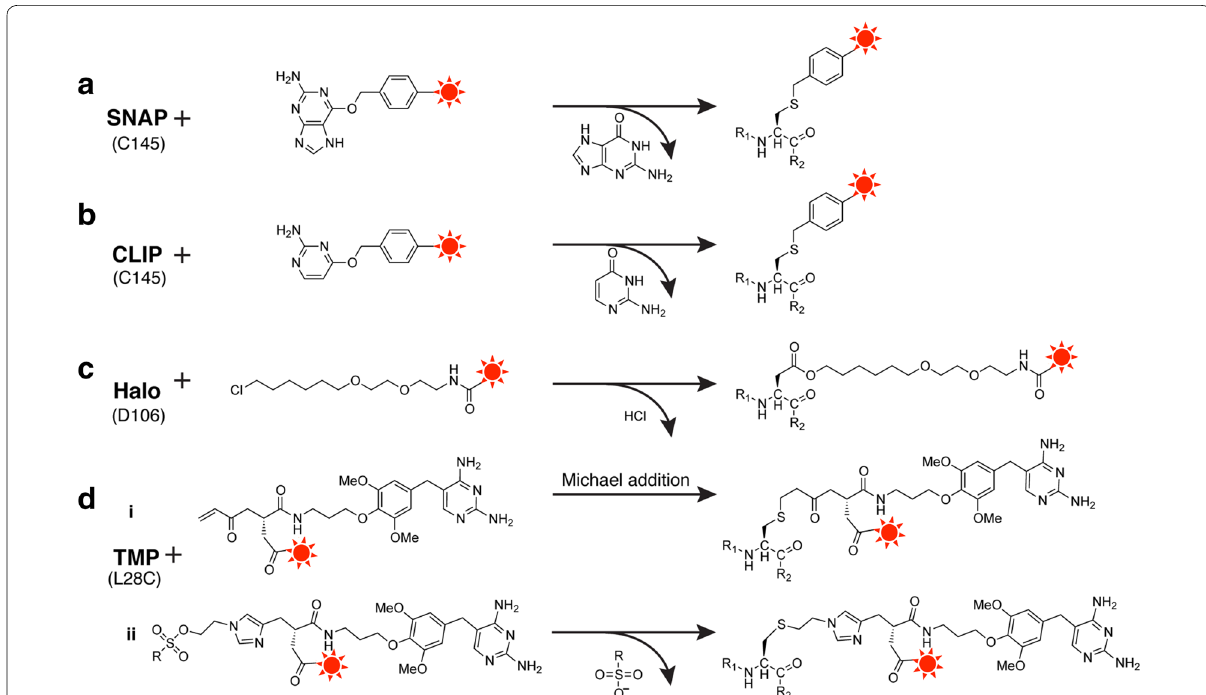
Fig. 24 Self-labeling protein tags. a , b Both SNAP- and CLIP-tag derive from O 6 -methylguanine-DNA methyltransferase with C145 as the active site. c The Halo-tag derives from haloalkane dehalogenase whose active site D106 forms an ester bond with the chloroalkane linker. d The TMP-tag non- covalently binds with trimethoprim and brings the α, β-unsaturated carbonyl ( i ) or sulfonyl ( ii ) into proximity of the engineered reactive Cys (L28C) (Figure adapted with permission from: Ref. [229]. Copyright (2017) American Chemical